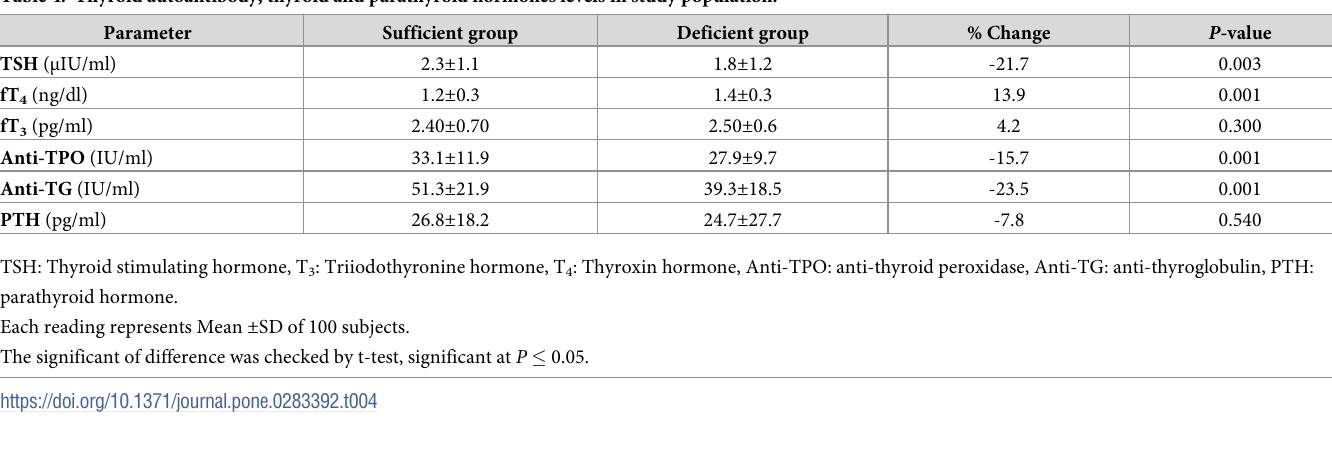
Table 4. Thyroid autoantibody, thyroid and parathyroid hormones levels in study